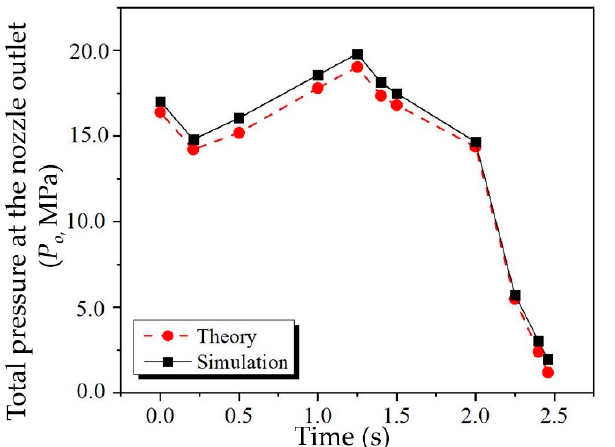
Figure 11. The Mach number ( M ) at the position x on the central line, which resulted from the simulation and the theory.